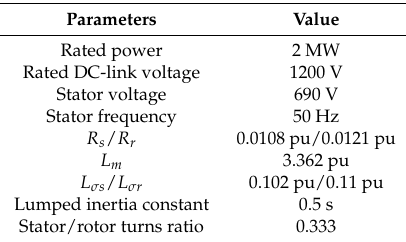
Table 1. DFIG Generator Parameters.